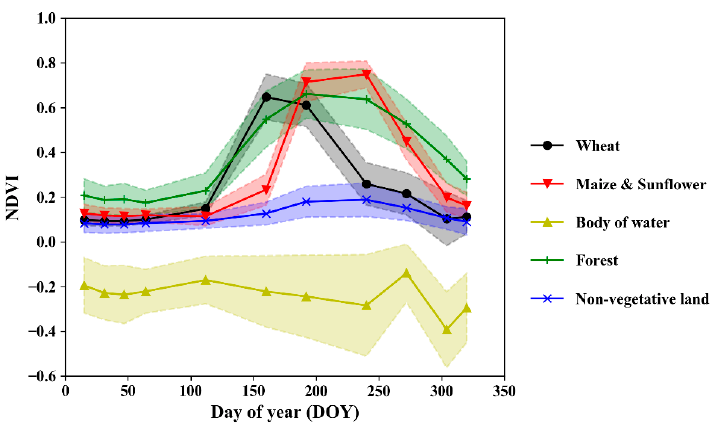
Figure 3. Examples of cluster centers with annual temporal NDVI in the Hetao Irrigation District in 2019. The shaded width area denotes the standard error (calculated by the NDVI value of all pixels in this class) for each group.